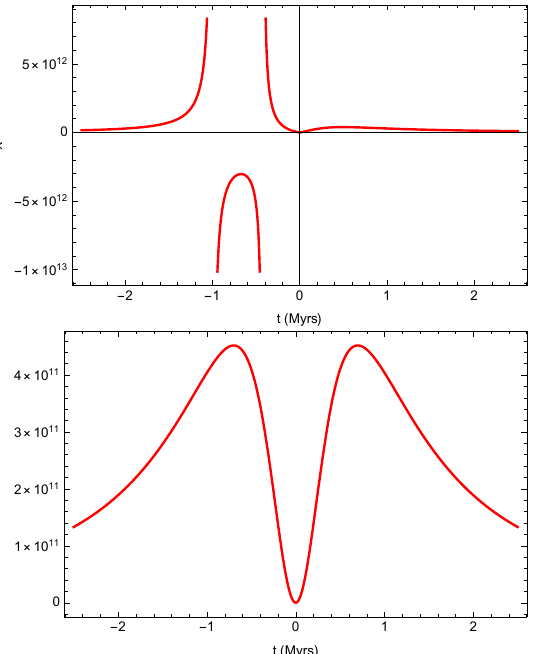
Figure 2. The behavior of the quantity χ ( R c , t ) as a function of the cosmic time, by choosing R c = 2.5 m 0 , for the values η = 5/2 (left plot) and also for η = 2 (right plot) and by also choos- ing c = 1.5 in Geometrized units. The plot in the left panel depicts the case for which a sudden singularity occurs at the time instance t = 0. As it can be seen, the photon orbits do not exist slightly before, during and after the sudden singularity. The numerical analysis was performed for 2 m 0 < R c ≤ 3 m 0 and the qualitative picture does not